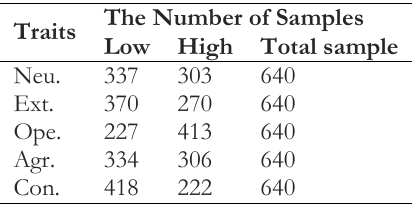
Table 1. The number of short audio clips at high and low levels in each trait at the SPC dataset. The imbalanced distribution is apparent.